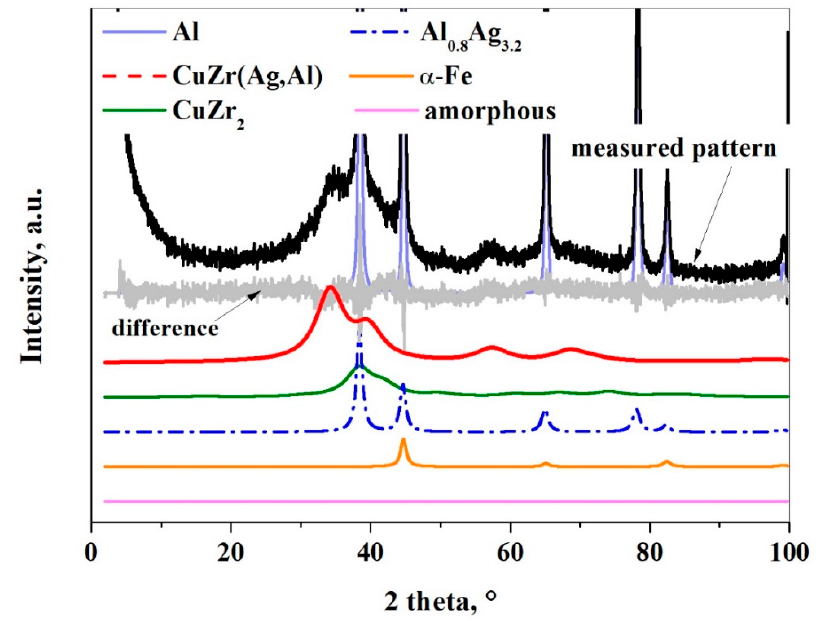
Figure 8. XRD pattern of the composite powder after 30 h milling time without using ethanol.